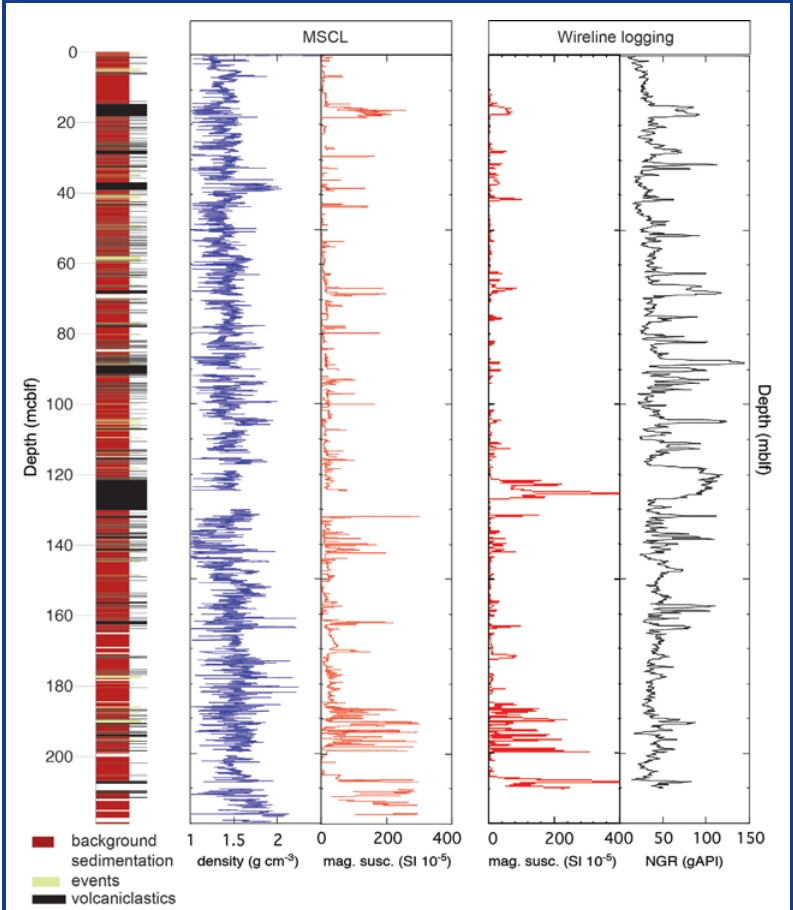
Figure 8. S implified lithologic log of the Ahlat Ridge composite section (on the basis of visual core descriptions after core opening) distinguishing background sediments (laminated or banded), volcaniclastic layers and event layers (e.g., turbidite deposits or other mass-movement related deposits). Log is juxtaposed to multisensor core logger (M S CL) data (wet bulk density, magnetic susceptibility ) and, on the independent logging depth scale, magnetic susceptibility and natural gamma ray (NGR) as measured by the wireline tools. Note good match between volcaniclastic layers and high magnetic susceptibility and gamma ray values. Note also how wireline logging magnetic susceptibility matches M S CL data and is able to fill gaps of low core recovery. Core-based data plotted in meters composite below lake floor (mcblf), wire-line logging data in meters below lake floor